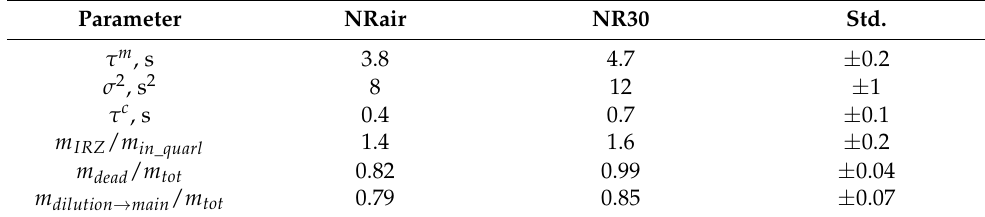
Table 3. Selected properties of the CRN model: non-reactive case.